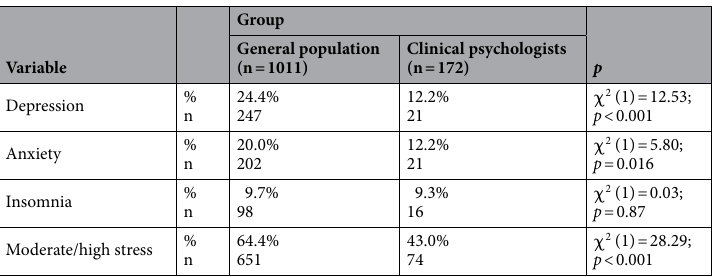
Table 1. Proportion of participants exceeding the cut-off scores for moderate depression/anxiety/insomnia and stress by group (n = 1183). p : p -values (2-tailed); χ 2 : Chi-squared-test; Depression: ≥ 3 points on the Patient Health Questionnaire 2 scale; Anxiety: ≥ 3 points on the Generalized Anxiety Disorder 2 scale; Insomnia: ≥ 6 on the 2-item Insomnia Severity Index; Moderate/High Stress: ≥ 14 points on the Perceived Stress Scale 10.